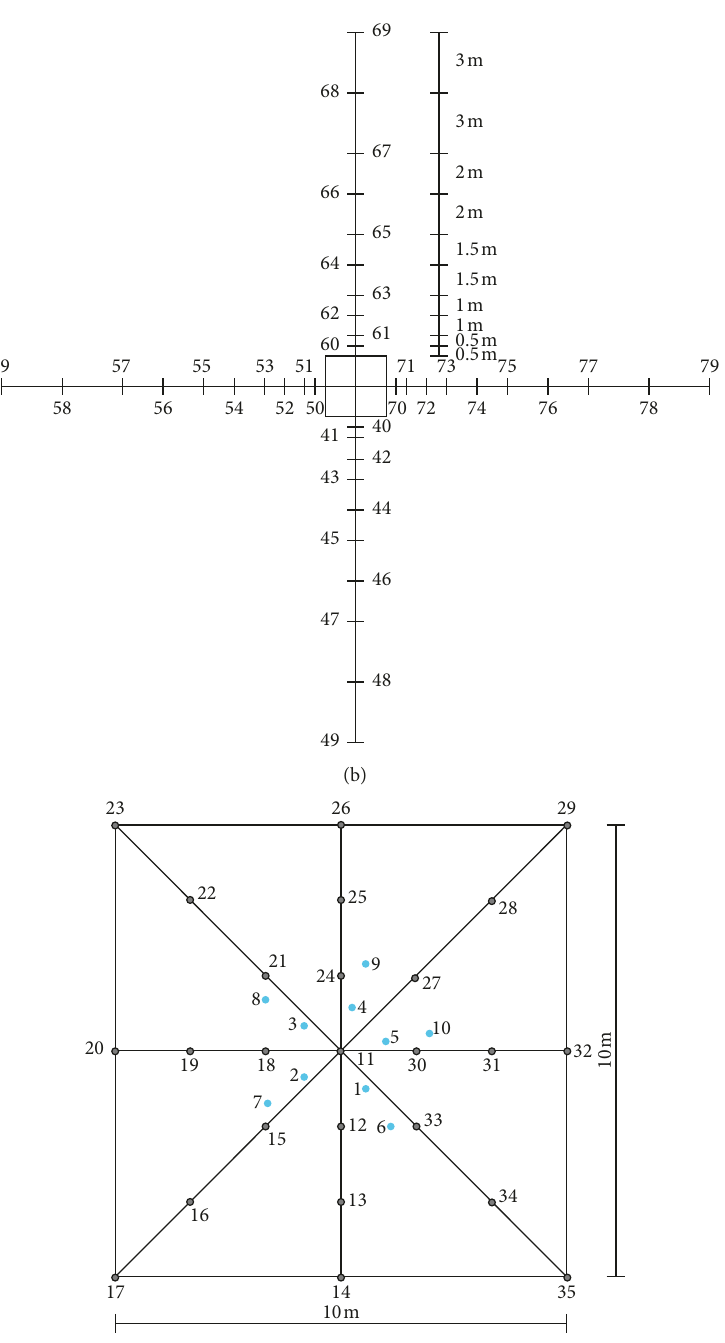
Figure 4: (a) The structure profile of three kinds of benchmarks for measuring collapsibility. (b) Layout of benchmarks outside the test pit. The four constant benchmarks (benchmarks 49, 59, 69, and 79) farthest from the center of test pit are generally to provide a standard for other benchmarks to be used to measure collapsibility. (c) Layout of benchmarks inside the test pit. The light blue ones are deep-buried steel pipe benchmarks used to measure collapsibility of loess at a specific depth, while other benchmarks are used to measure the total col- lapsibility inside the